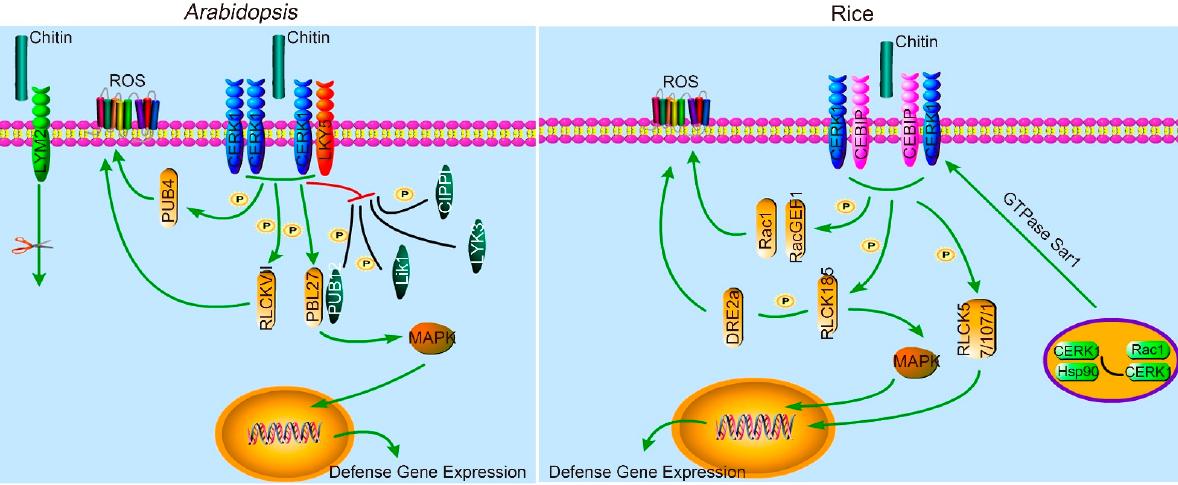
Figure 1. A model for fungal chitin-triggered immune signals involving LysM domain proteins in plants. LYM2: lysin motif domain-containing glycosylphosphatidylinositol-anchored protein 2; ROS: reactive oxygen species; CERK1: chitin elicitor receptor kinase 1; LYK5: LysM receptor kinase 5; PUB4: plant U-box protein 4; RLCK VII: receptor-like cytoplasmic kinase VII; PBL27: probable serine/threonine protein kinase-like 27; PUB12: plant U-box protein 12; Lik1: LysM RLK1- interacting kinase 1; LYK3: LysM receptor kinase 3; CIPP1: CERK1-interacting protein phosphatase 1; MAPK: mitogen- activated protein kinase; P: phosphorylation; CEBiP: chitin exciton-binding protein; Rac1: a member of Rho family (GTPases) ; RacGEF1: guanine nucleotide exchange factor for OsRac1; DRE2a: rice homologs of the yeast Dre2 protein; RLCK185: Oryza sativa receptor-like cytoplasmic kinase 185; RLCK57/107/118/76: receptor-like cytoplasmic kinase 57/107/118/76; GTPase Sar1: GTPase secretion-associated and ras-related protein 1; Hsp90: heat shock protein 90.